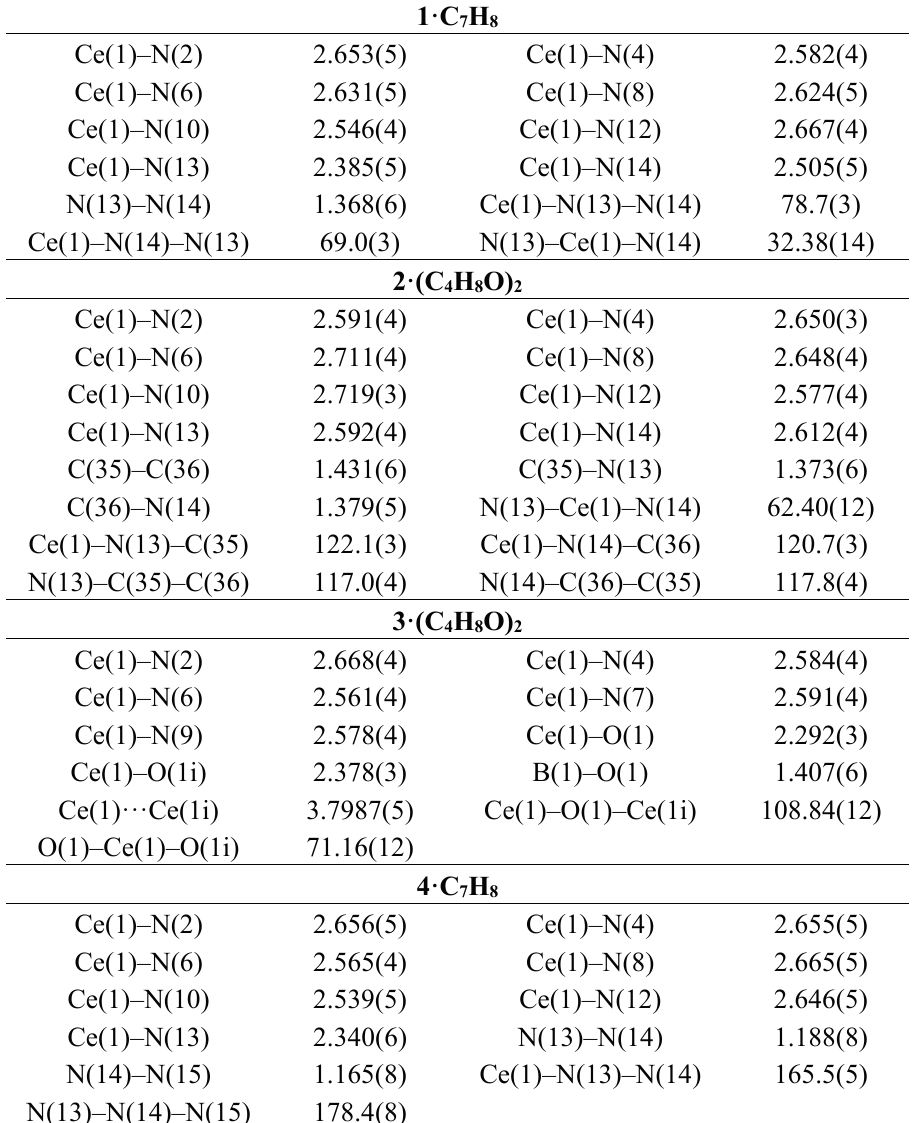
Table 1. Selected bond lengths (Å) and angles (°) for 1 – 4